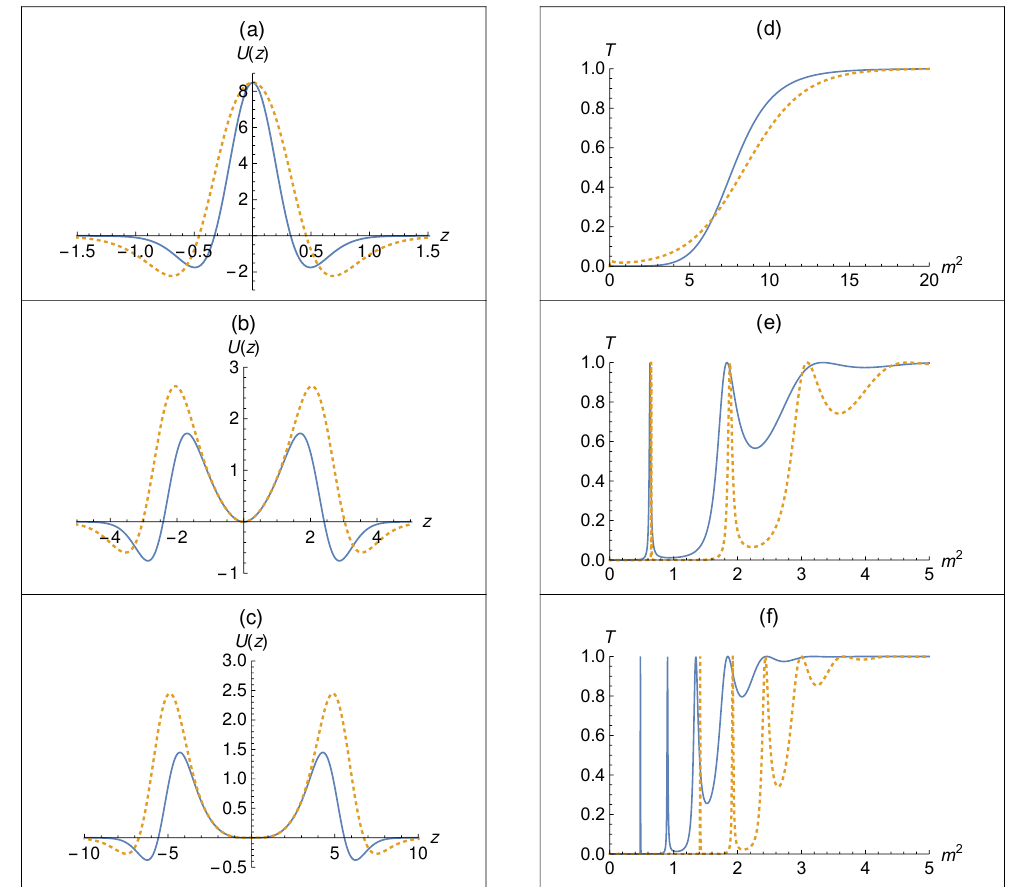
Figure 4 . Potentials U ( z ) and Transmission coe(cid:14)cient T ( m 2 ) for massive right fermions (odd dimensions) and Dirac fermions (even dimensions choosing (cid:24) n + ( x )) with (cid:21) = 0 ; 4 for D = 5 (line) and D = 10 (dotted), with (cid:17) = 1, M = 1 and s = 1 (a, d), s = 3 (b, e) and s = 5 (c,